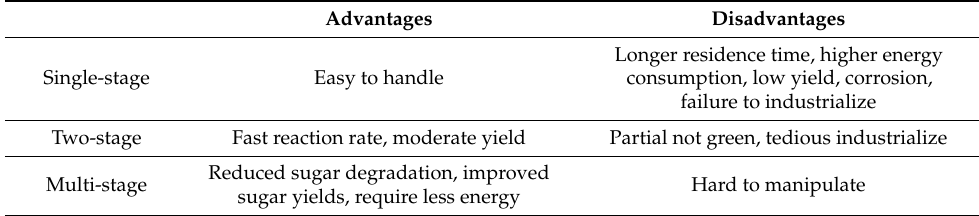
Table 1. Single, two-stage or multi-stage approaches.